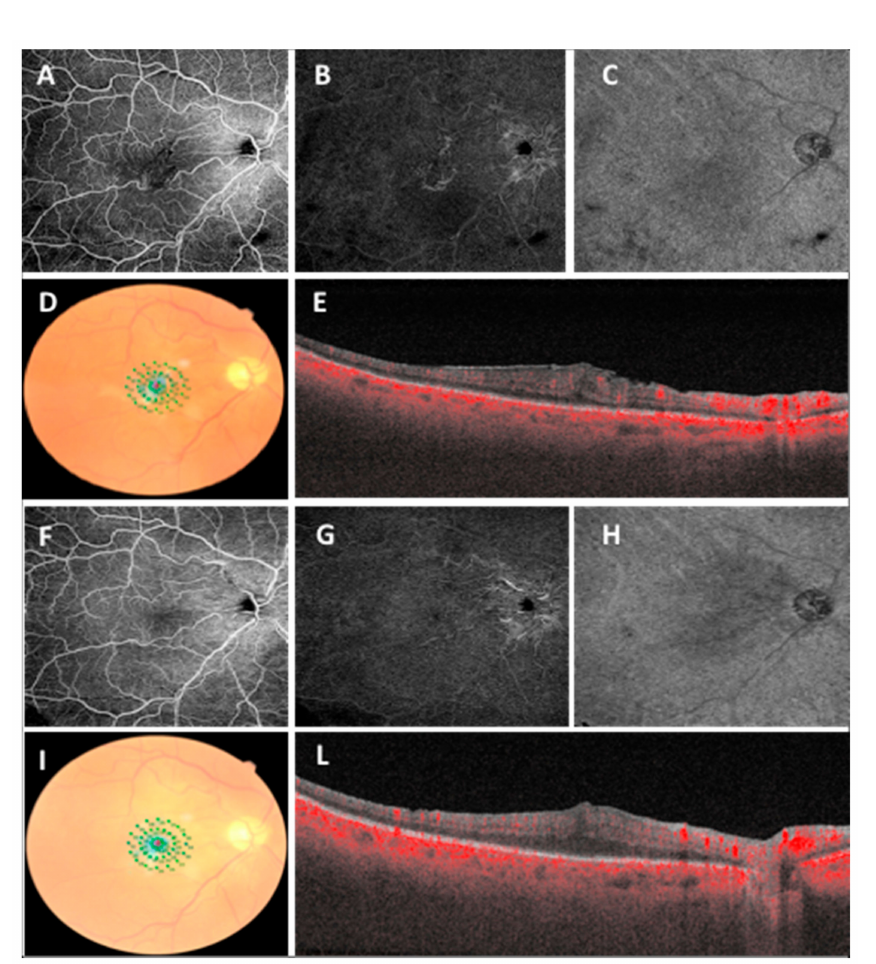
Figure 3. Widefield OCTA scans (12 × 12 mm) of superficial capillary plexus ( A ), deep capillary plexus ( B ), choriocapillaris ( C ), microperimetry ( D ) and OCT scan ( E ) before vitreoretinal surgery in epiretinal membrane. Widefield OCTA scans (12 × 12 mm) of superficial capillary plexus ( F ), deep capillary plexus ( G ), choriocapillaris ( H ), microperimetry ( I ) and OCT scan ( L ) at 3-month